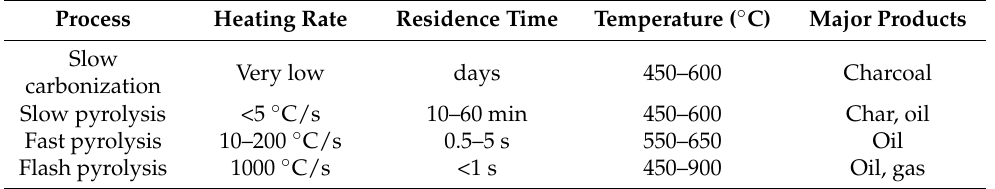
Table 1. Pyrolysis processes based on operating conditions and targeted products adapted from [8,25].